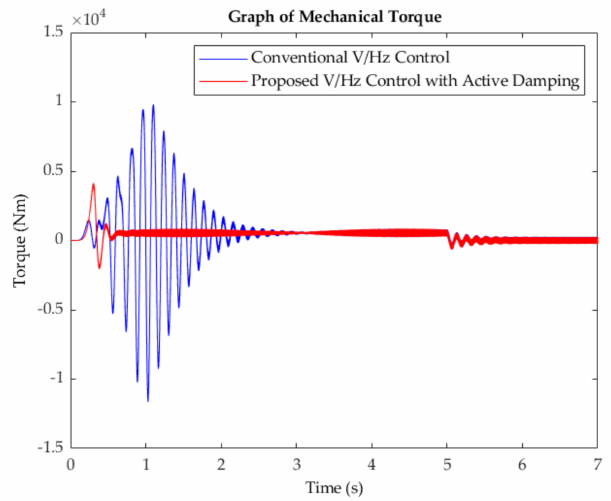
Figure 16. Mechanical torque—active damping technique (red) vs. conventional V/Hz (blue).